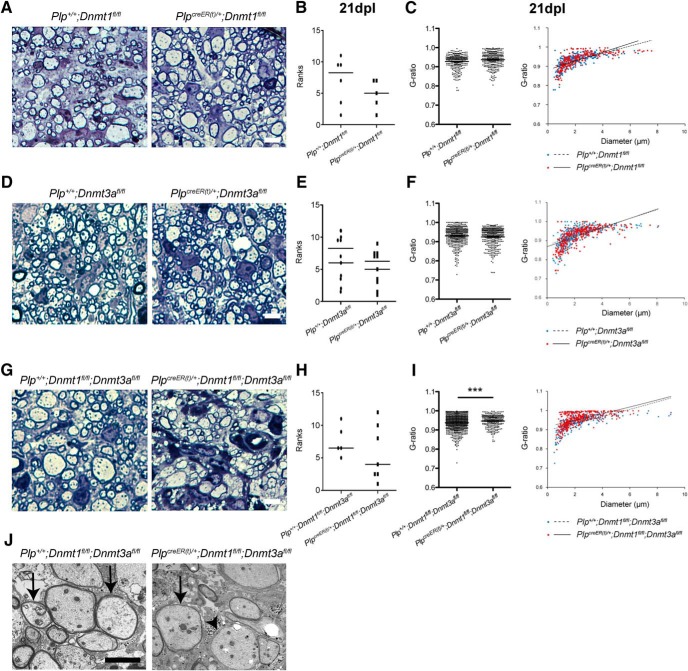
Ablation of Dnmt1 and Dnmt3a impairs remyelination in the adult spinal cord. A, Representative semithin sections at 21 dpl in tamoxifen-treated Plp+
/+;Dnmt1fl/fl and PlpcreER(t)
/+;Dnmt1fl/fl spinal cords. B, Relative ranking of remyelinations (p = 0.3075). C, Quantification of g-ratios for control and mutants mice, and plot of g-ratios against axonal diametert (p = 0.9426). D, Representative semithin sections at 21 dpl in tamoxifen-treated Plp+
/+;Dnmt3afl/fl and PlpcreER(t)
/+;Dnmt3afl/fl spinal cords. E, Relative ranking of remyelinationu (p = 0.7144). F, Quantification of g-ratios for control and mutants mice, and plot of g-ratios against axonal diameterv (p = 0.1079). G, Representative semithin sections at 21 dpl in tamoxifen-treated Plp+
/+;Dnmt1fl/fl;Dnmt3afl/fl and PlpcreER(t)
/+;Dnmt1fl/fl;Dnmt3afl/fl spinal cords. H, Relative ranking of remyelinationx (p = 0.7584). I, Quantification of g-ratios for control and mutants mice, and plot of g-ratios against axonal diametery (p = 0.0005). J, Representative electron microscopic sections at 21 dpl in tamoxifen-treated Plp+
/+;Dnmt1fl/fl;Dnmt3afl/fl and PlpcreER(t)
/+;Dnmt1fl/fl;Dnmt3afl/fl spinal cords revealing new thin myelin sheaths of remyelination (arrows) and a demyelinated axon (arrowhead). Scale bar = 10 µm. Dots are ranking for each mouse (B, E, H) and g-ratio for each quantified axon (C, F, I). Data are mean ± SEM. n = 3–5 animals, >70 axons per animal. ***p < 0.01 (Mann–Whitney test and Student’s t test).